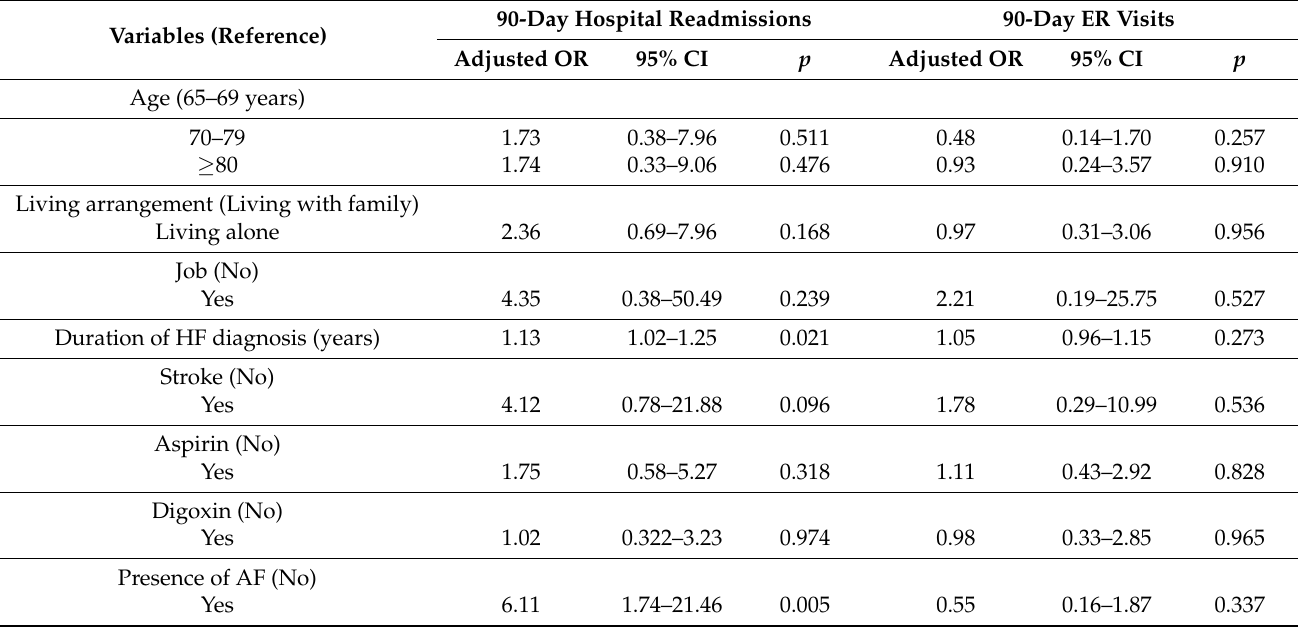
Table 4. Multivariate logistic regression analysis of 90-day hospital readmissions and ER visits in older female patients with HF ( n =